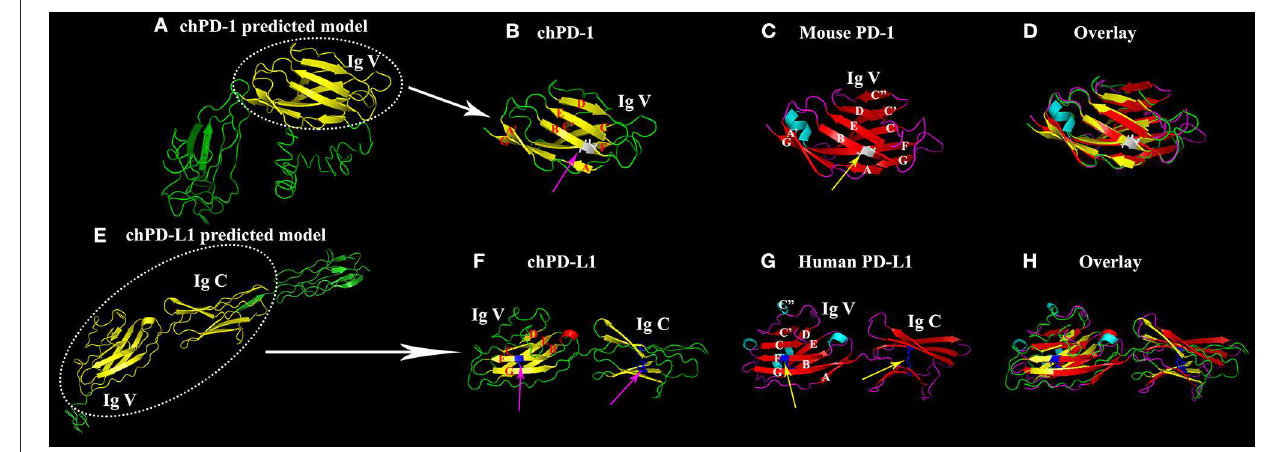
FIGURE 2 | Similarity of the Ig V domain of chPD-1 to the Ig V domain of mouse PD-1 and the Ig V and Ig C domains of chPD-L1 to the Ig V and Ig C domains of human PD-L1. (A,E) Predicted homology structural models of chPD-1 and chPD-L1 by I-TASSER software. Although difference in the number of presence of β sheets, the overall structures have identical orientations. (B–D) Overlay of Ig V domains of chPD-1 with Ig V mouse PD-1. (B) The Ig V domain of chPD-1 is shown in yellow, and (C) the Ig V domain mouse PD-1 is shown in red. In mouse PD-1, the two β -sheets are labeled A’GFCC’C” and ABED. In chPD-1, C” and C-terminal of G are absent. The cysteine residues at 48 and 116 form intrachain disulfide bonds are drawn as balls and sticks, and are shown in gray (pink arrow for chPD-1 and yellow arrow for mouse PD-1). (F–H) Overlay of Ig V and Ig C domains of chPD-L1 with human PD-L1. (F) The Ig V and Ig C domains of chPD-L1 is shown in yellow, and the (G) Ig V and Ig C domains of human PD-L1 is shown in red. In human PD-L1, the two β -sheets are labeled AGFCC’C” and BED. In chPD-L1, A, C’, and C” are absent. The cysteine residues at 43 and 120 of Ig V domain and at 133 and 225 of Ig C domain form intrachain disulfide bonds are drawn as balls and sticks, and are shown in blue (pink arrow for chPD-L1 and yellow arrow for human PD-L1). Both chPD-1 and chPD-L1 were showed in same view, respectively.